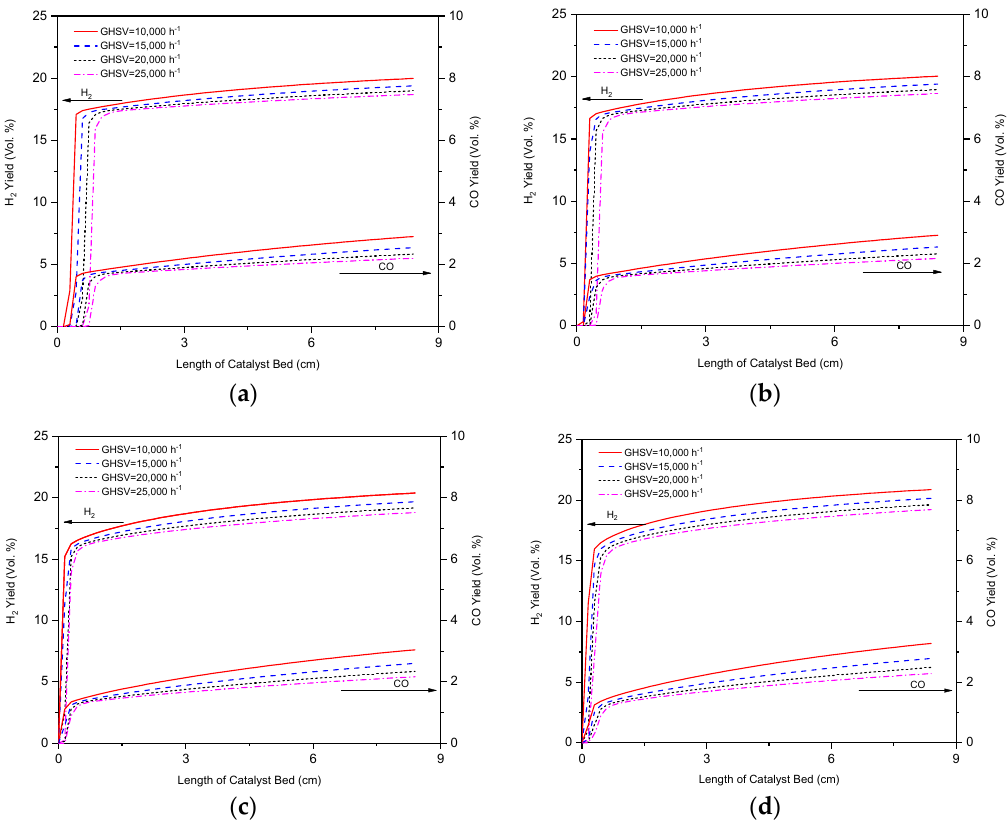
Figure 3. GHSV conditions: 10,000, 15,000, 20,000 and 25,000 1/h at different reaction temperatures: ( a ) 400 °C; ( b ) 450 °C; ( c ) 500 °C; ( d ) 550 °C.